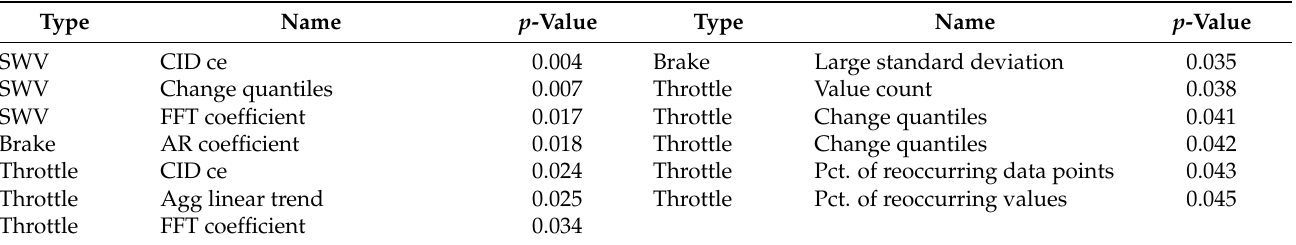
Table 1. Significant feature list for long duration of drowsy driving (LD) data.